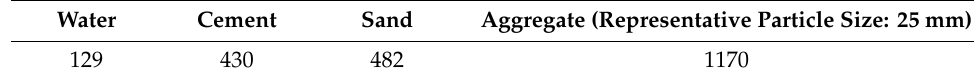
Table 1. Mixture proportion of concrete in the unit of kg / m 3 . Table 1 . Mixture proportion of concrete in the unit of kg/m 3 .